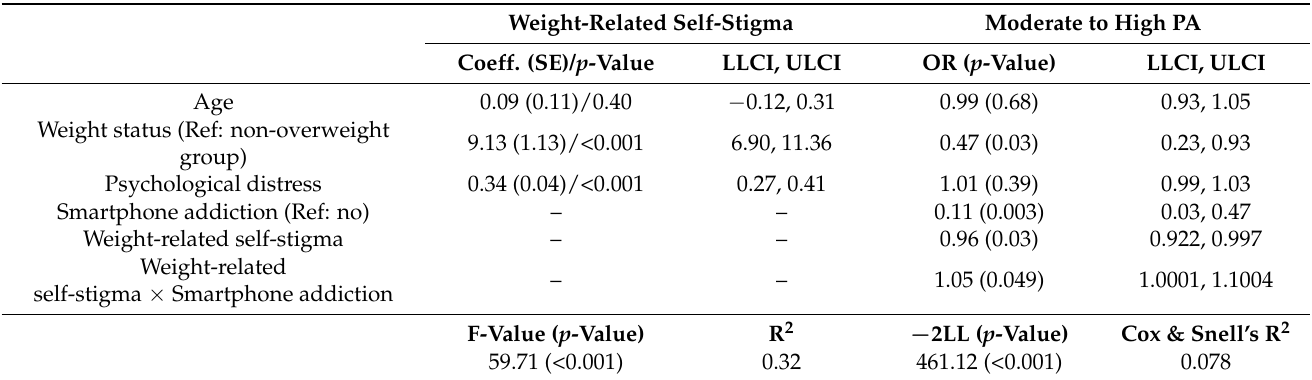
Table 3. Multivariate regression models explaining moderate to high physical activity (PA) among female university students (N = 391). Weight-Related Self-Stigma Moderate to High PA Coeff. (SE)/ p -Value LLCI, ULCI OR ( p -Value) LLCI, ULCI 0.09 (0.11)/0.40 0.93,